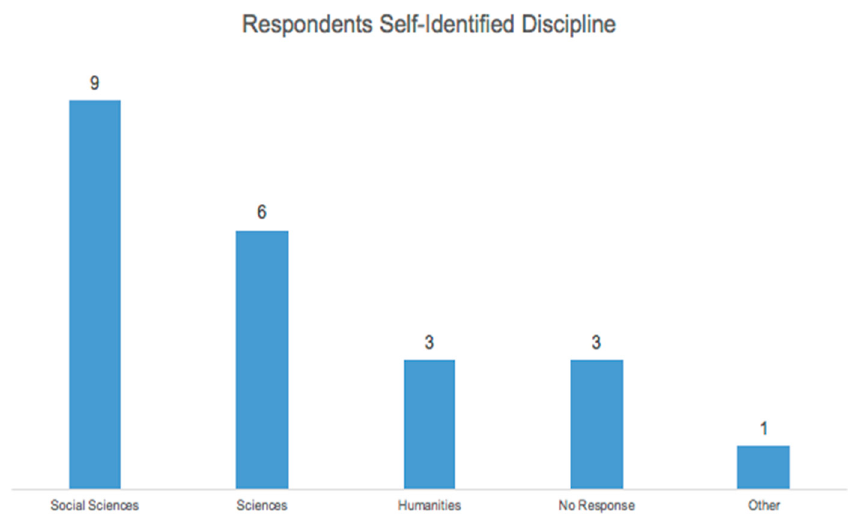
Figure 7. Respondents Self-Identified Discipline.